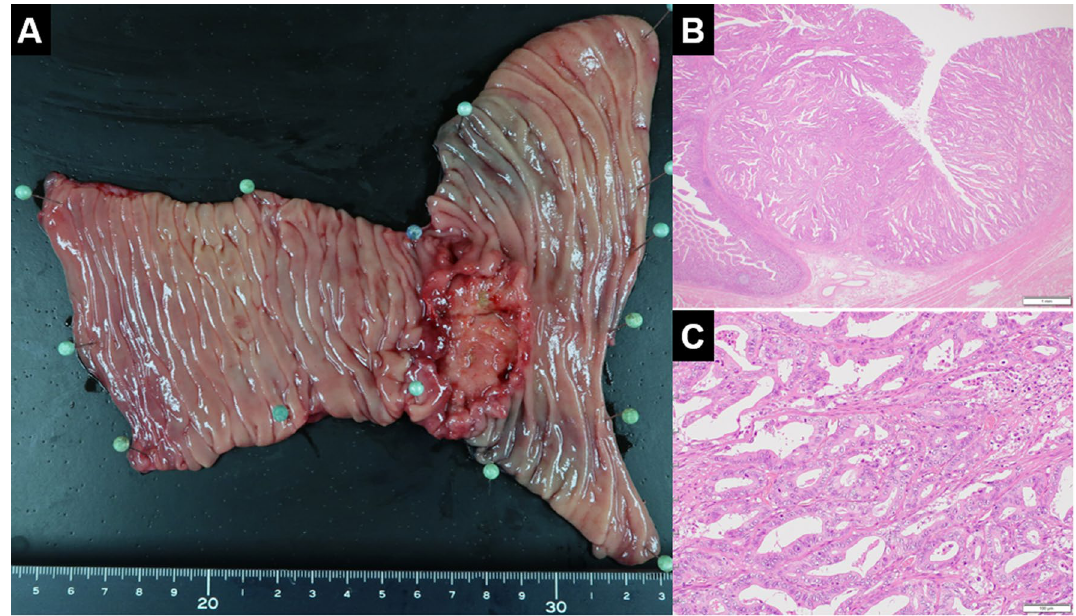
Fig. 2 A The tumor was 60 35 mm in size in the third duodenal portion. B , C Pathological tests revealed that the carcinoma originated from the × duodenal membrane and was well differentiated